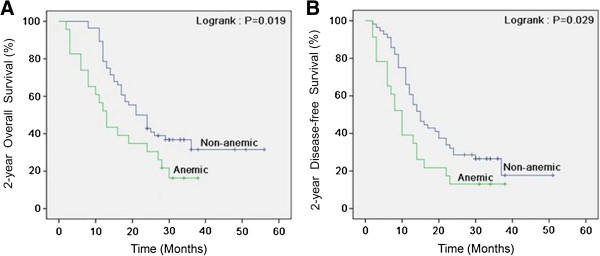
Kaplan-Meier curves for survival of 79 patients with esophageal squamous cell carcinoma (non-anemic versus anemic). Both 2-year overall survival (A) and disease-free survival (B) between two groups remained statistically significant.